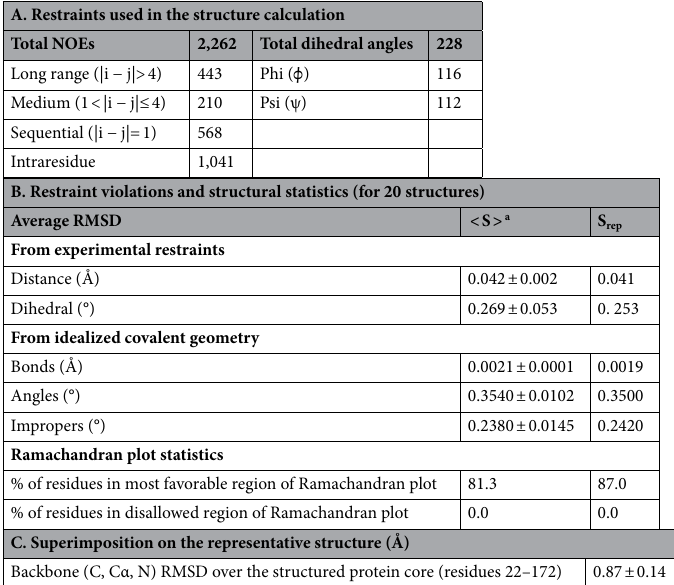
Table 1. Statistics for the ensemble of the calculated 20 structures of the HpEst3. No NOE or dihedral angle violations are above 0.5 Å and 5° respectively. a < S > is the ensemble of 20 final structures; S rep is the representative structure, selected from the final family on the criteria of having the lowest sum of pairwise RMSD for the remaining structures in the